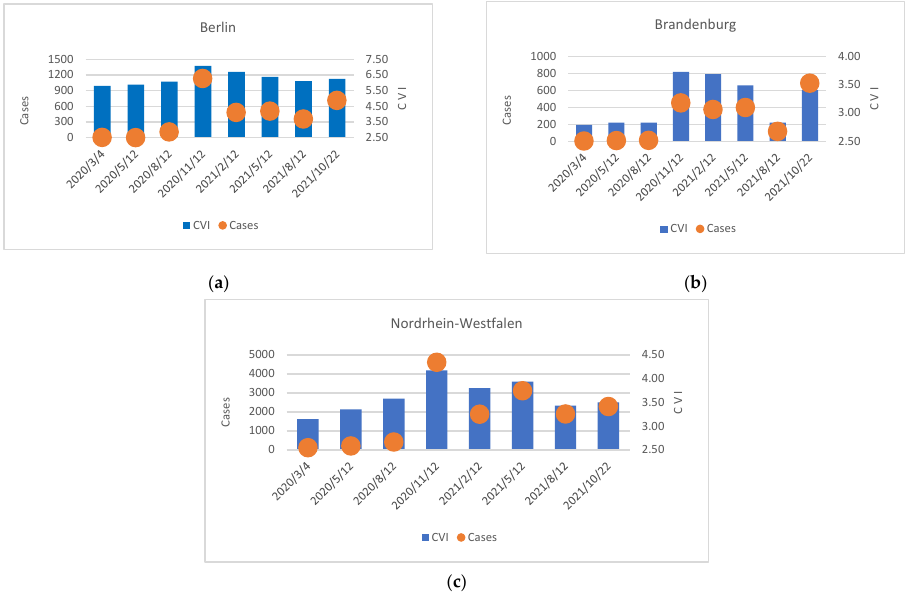
Figure 15. CVI and COVID-19 confirmed cases in ( a ) Berlin, ( b ) Brandenburg and ( c ) Nordrhein- Westfalen.